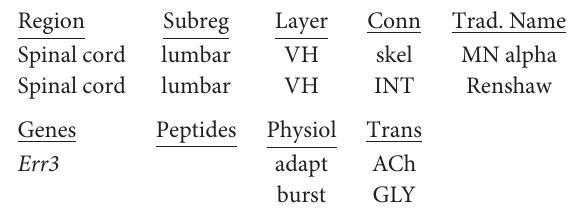
FIGURE 2 | Neostriatum, showing the direct and indirect principal neuron projections to the globus pallidus interna by the medium spiny neurons, and the several types of interneurons, including the large cholinergic interneuron [see text, adapted from Wilson